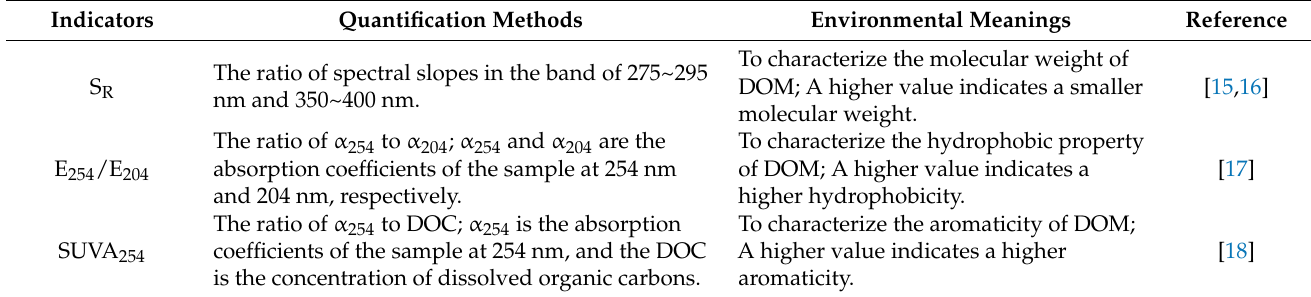
Table 2. The method and description of DOM